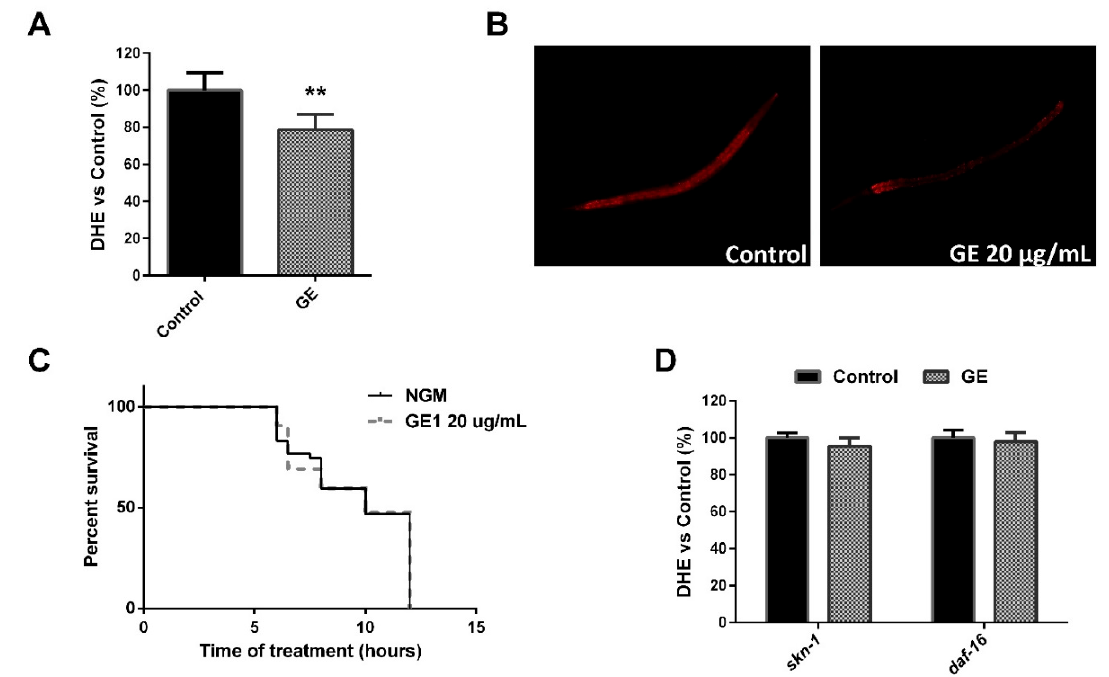
Figure 5. Grifola extract (GE) exhibits in vivo antioxidant activity. ( A ) Microscope detection of the ROS production (stained by DHE) in control and GE-treated (20 µ g/mL) worms. ( B ) Quantification of the ROS production (determined by DHE) in GE-treated worms in comparison with untreated control worms (mean ± SD relative to untreated control worms). Significance refers to the effect of GE with respect to untreated control worms (Student’s t -test, ** p < 0.01). ( C ) Percentage of survival during time (h) of control and GE-treated (20 µ g/mL) L4 worms incubated at 35 ◦ C. ( D ) DHE quantification of ROS production in GE-treated worms in comparison with untreated control worms for skn-1 and daf-16